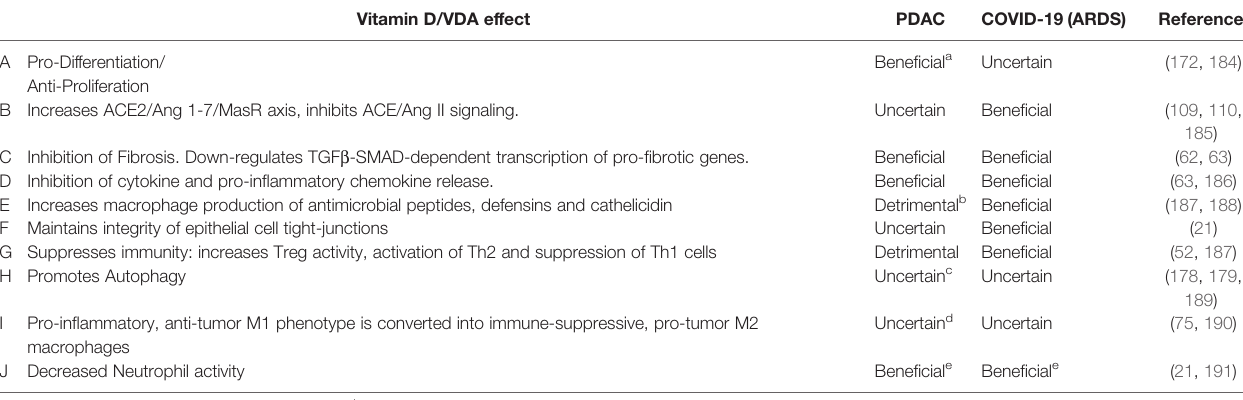
TABLE 6 | Predicted effects of VDAs in PDAC and